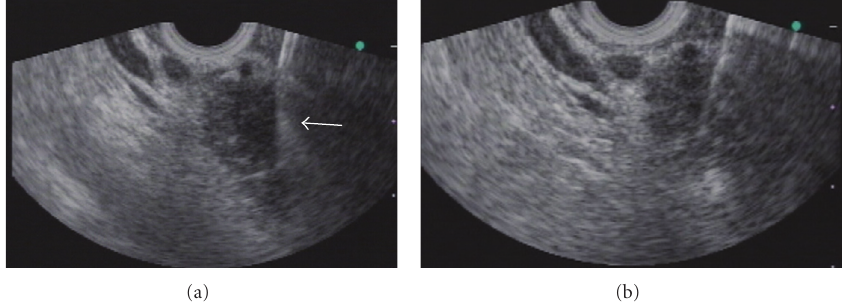
Figure 1: EUS-FNA images for pancreatic head cancer using (a) 22-gauge and (b) 25-gauge needles. The tip of the 22-gauge needle was bent within the lesion during the puncture, and no material was obtained. The arrow indicates the bent tip of the 22-gauge needle. The 25-gauge needle tip remained straight during the EUS-FNA procedure (arrow), and pancreatic adenocarcinoma was diagnosed with EUS-FNA using the 25-gauge